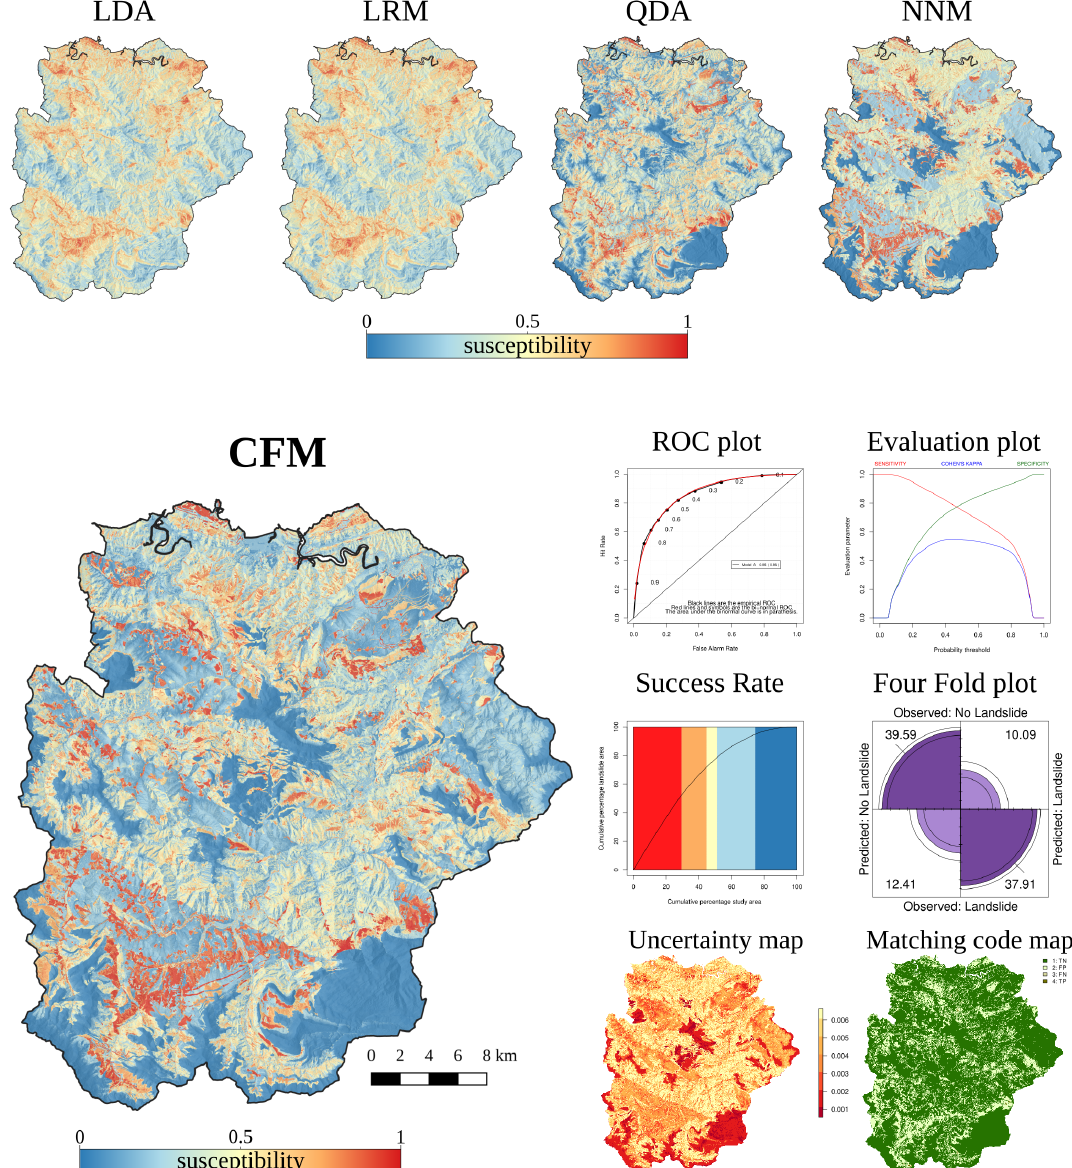
Figure 9. Examples of the most relevant outputs of LAND-SE obtained in the Gipuzkoa study area. LDA: linear discriminant analysis; LRM: logistic regression model; QDA: quadratic discriminant analysis; NNM: neural network analysis; CFM: combined model function.